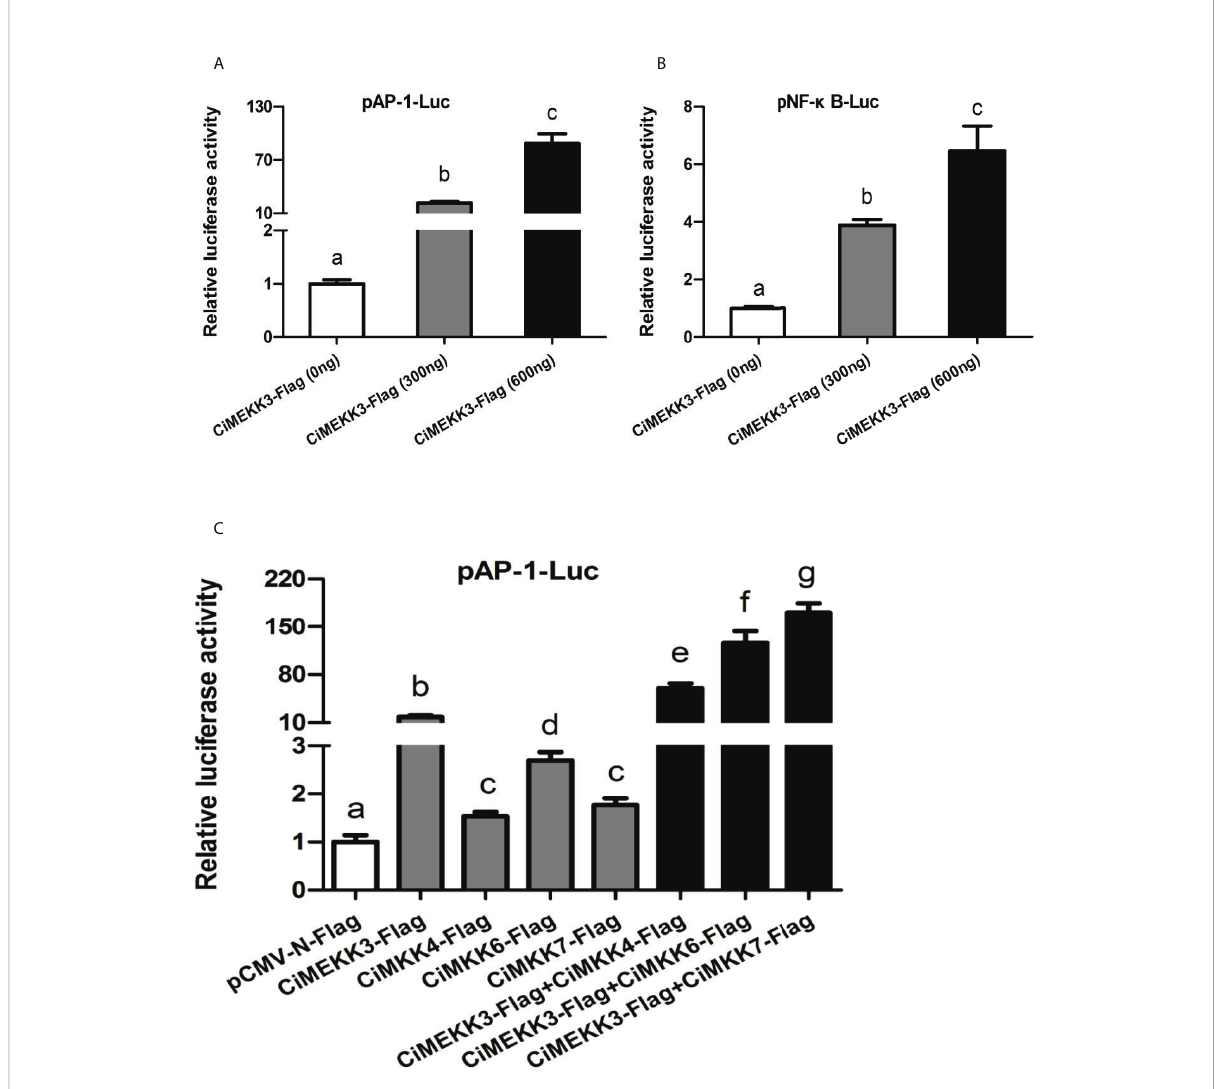
FIGURE 10 Effects of Ci MEKK3 overexpression on the activity of the AP-1 and NF- k B pathways. The Ci MEKK3-Flag (0, 300 and 600 ng/well) was cotransfected with 100 ng/well AP-1-Luc (A) or NF- k B-Luc (B) into HEK293T cells. (C) Ci MEKK3-Flag (300 ng/well) was cotransfected with 100 ng/well AP-1-Luc, 300 ng/ well Ci MKK4-Flag, Ci MKK6-Flag or Ci MKK7-Flag into HEK293T cells. Each bar represents the mean (three replicates) ± standard deviation. Fire fl y and Renilla luciferase activities were detected in cell lysates 48 h after transfection. Data are the fold changes relative to the empty vector transfected cells. Signi fi cant differences are indicated with different letters ( P <